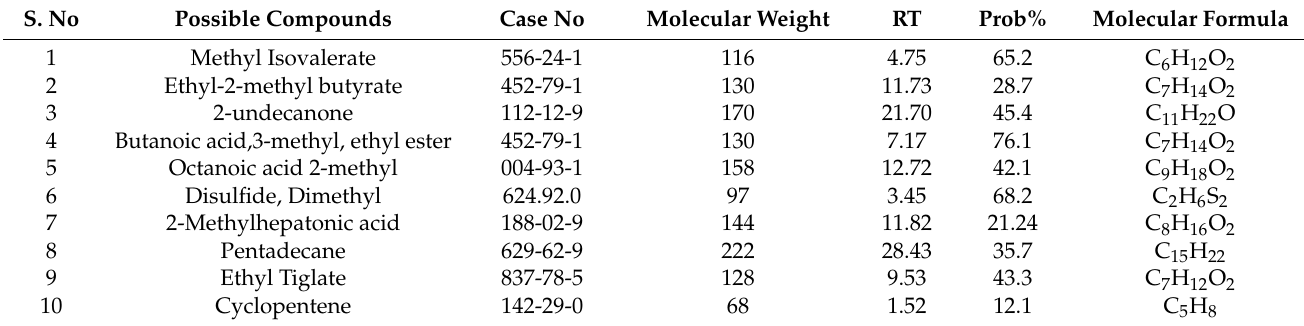
Table 1. The possible volatile organic compounds (VOCs) produced by GBSC56 were purchased from Sigma-Aldrich company supplier, Shanghai, China. S. No Possible